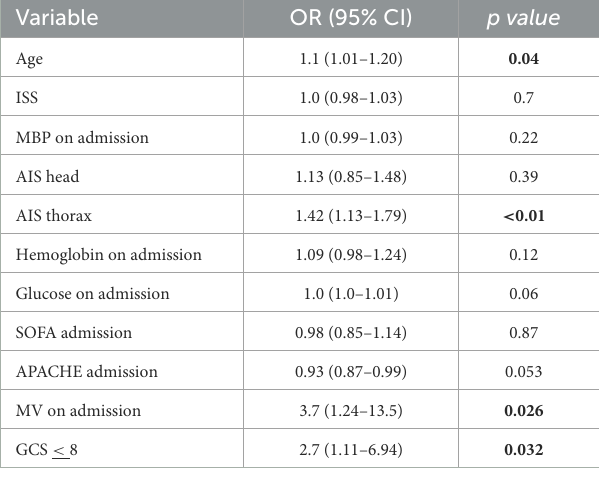
TABLE 3 Multivariate logistic regression analysis for LRTI in TBI patients admitted to